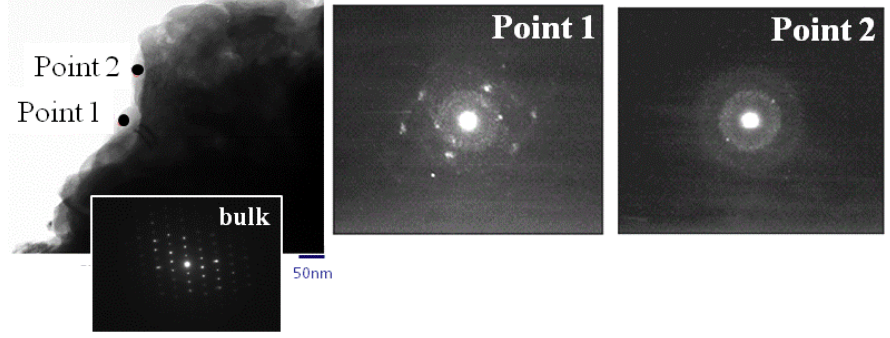
Figure 5. Transmission electron microscopy (TEM) of S-Mn-V diffraction at Points 1 and 2.